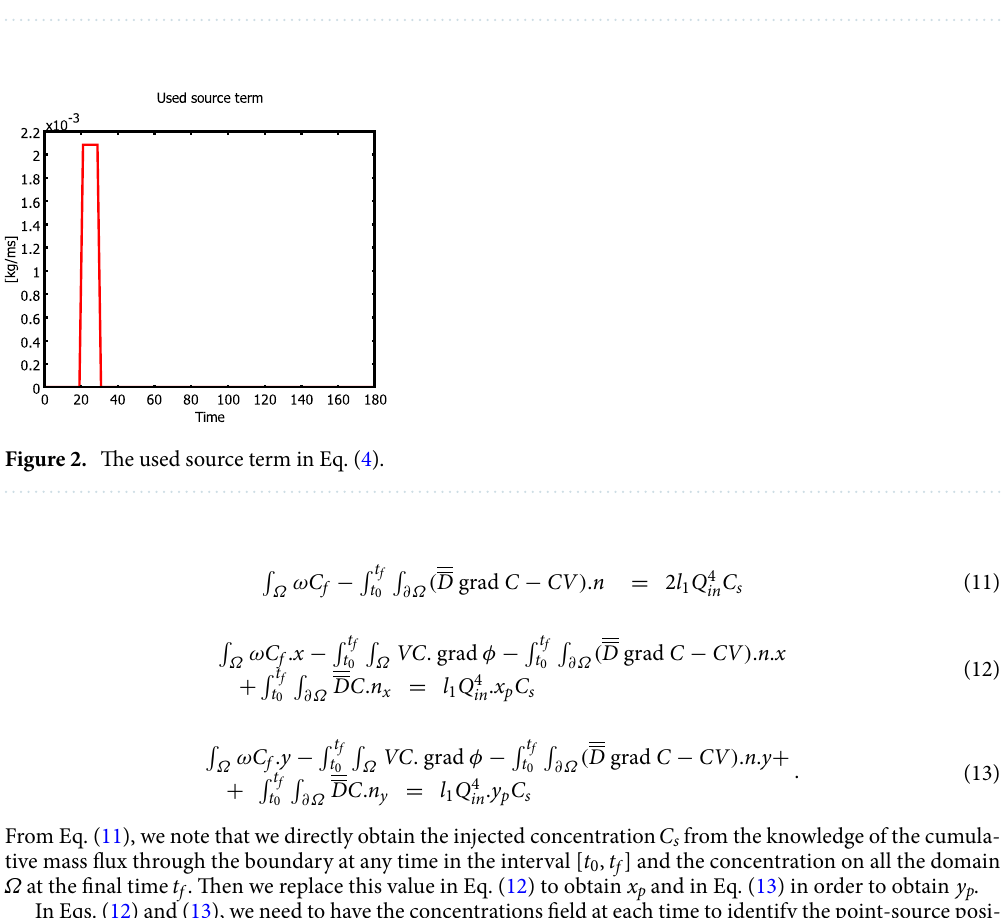
Figure 1. Rocky Mountain aquifer proprieties (where T1, T2 and T3 are the respective domains’ transmissivity).